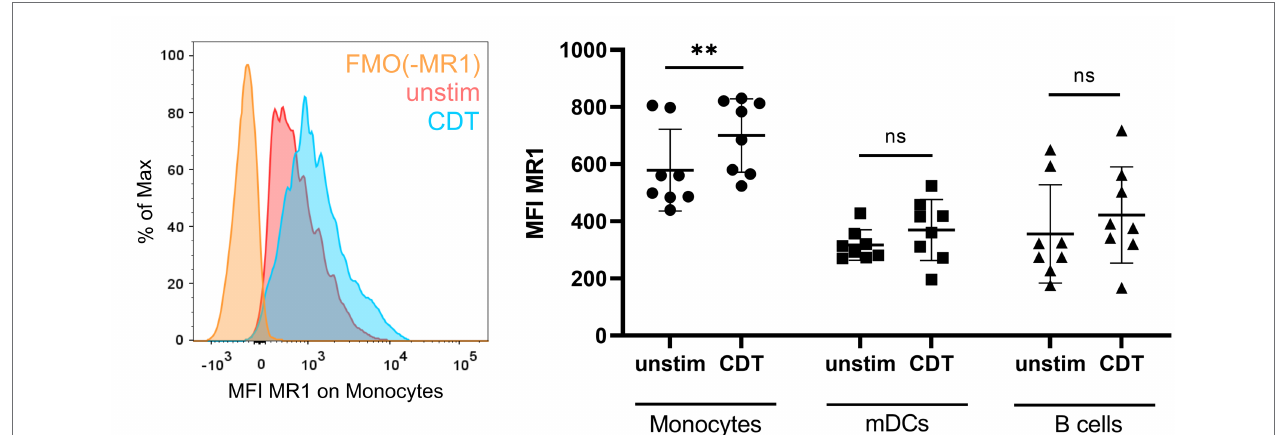
FIGURE 5 | C. difficile CDT-induced MR1 surface expression on monocytes. PBMCs were isolated from human donors and either left untreated or stimulated with 100 ng/ml C. difficile CDT for 20 h followed by flow cytometric analysis of MR1 expression. Left: Representative histogram of MR1 surface expression (MFI) on unstimulated (red) and CDT-stimulated (blue) CD14 + monocytes. Fluorescence minus one (FMO) staining for MR1 is shown (orange). Right: MR1 surface expression of unstimulated or CDT-stimulated CD14 + monocytes, myeloid dendritic cells (mDCs), and B cells. Horizontal lines indicate mean ± SD. Asterisks indicate significant differences determined by Wilcoxon matched-pairs signed rank tests: ** p < 0.01. Data of two independent experiments from 10 donors are